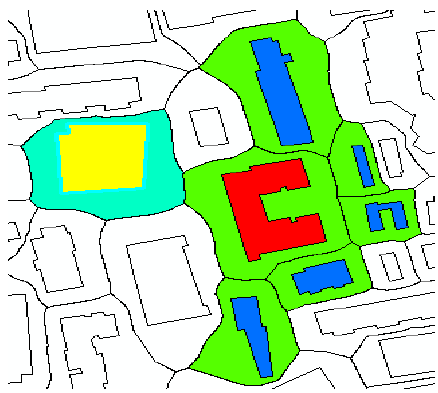
Figure .2 Two segmentation schematic of a single visual